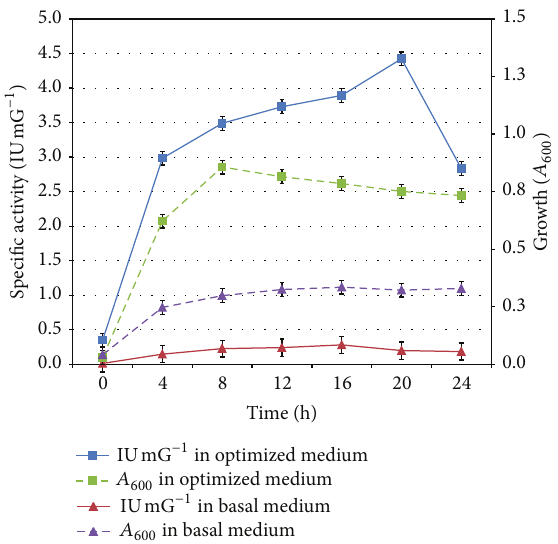
Figure 14: Time course of specific ADI activity and growth of E. faecium sp. GR7 in optimized and basal (TGYE) medium. Results are expressed as the mean ± S.D ( 𝑛 = 3 ), 𝑃 -value <